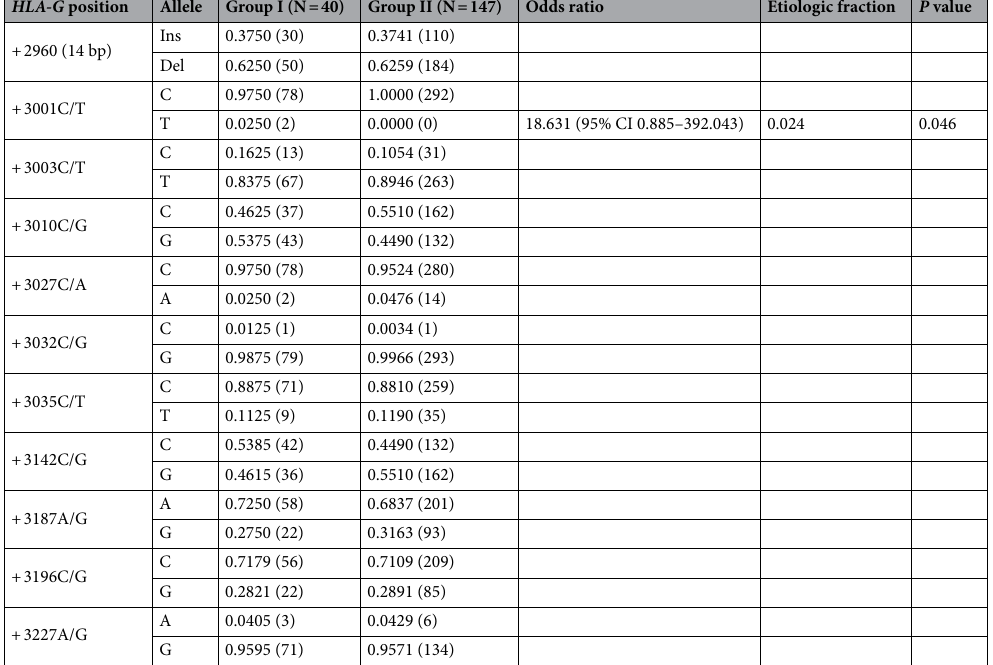
Table 1. Frequency and absolute number of the HLA-G 3 ′ UTR alleles observed in patients with AIDS exhibiting CMV retinitis (CMV-R: Group I) and in patients with AIDS without CMV-R (Group